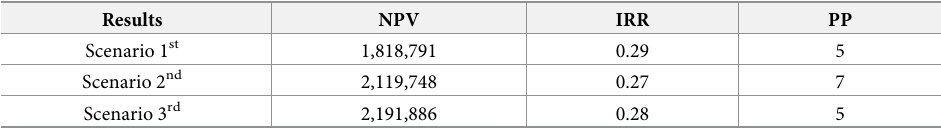
Table 9. The results of the financial models of the three proposed